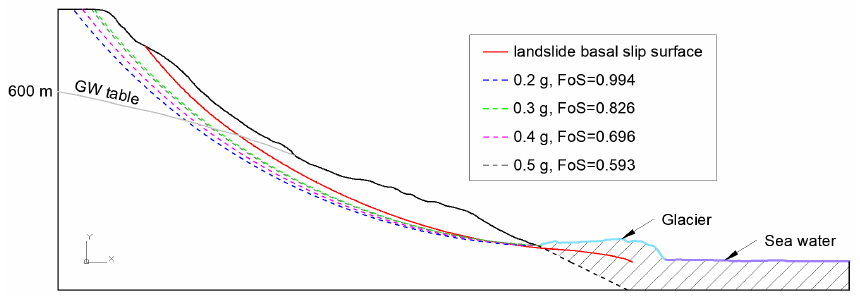
Figure 10. Sliding surfaces obtained under different seismic acceleration conditions for Set 1.